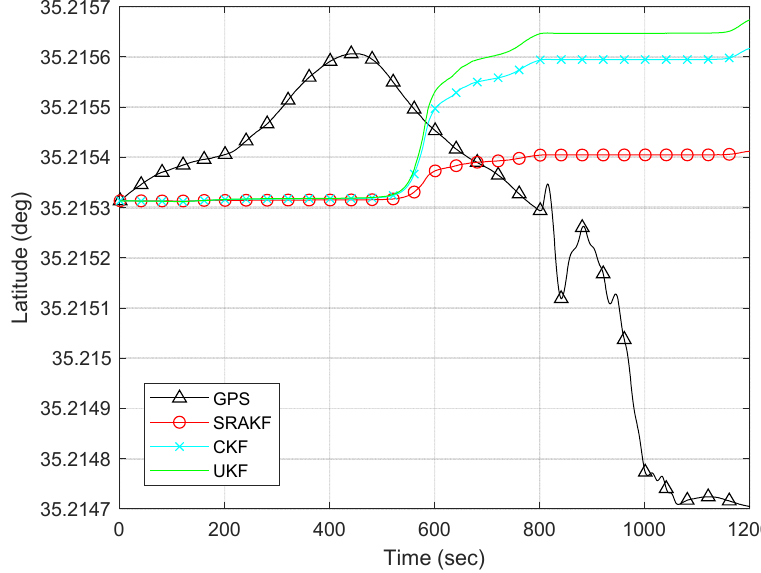
Figure 7. Latitude positions for the surface lake trial.